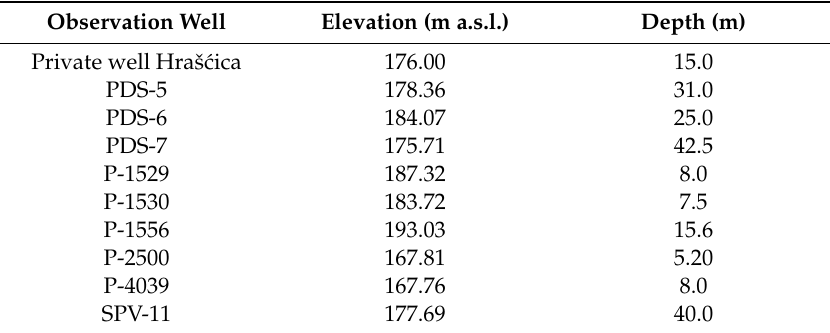
Table 5. Depths of the observation